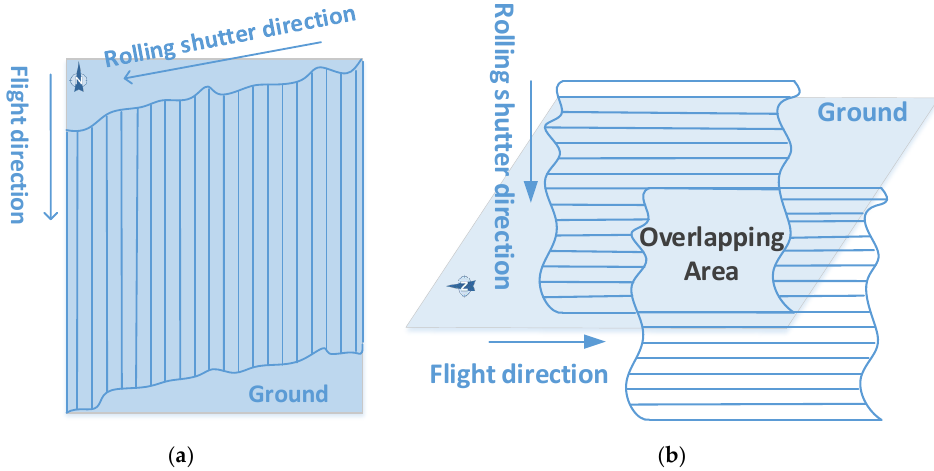
Figure 2. The schematic diagram of the jitter detection principle using CMOS images by rolling shutter. ( a ) Imaging coverage of CMOS sensor with rolling shutter under jitter condition; ( b ) Overlapping area of two adjacent CMOS images by rolling shutter.